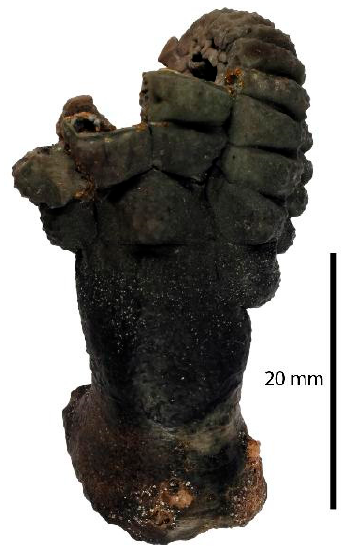
Figure 22. Specimen of Holopus rangii crinoid. Muséum national d’Histoire naturelle, Paris (France),